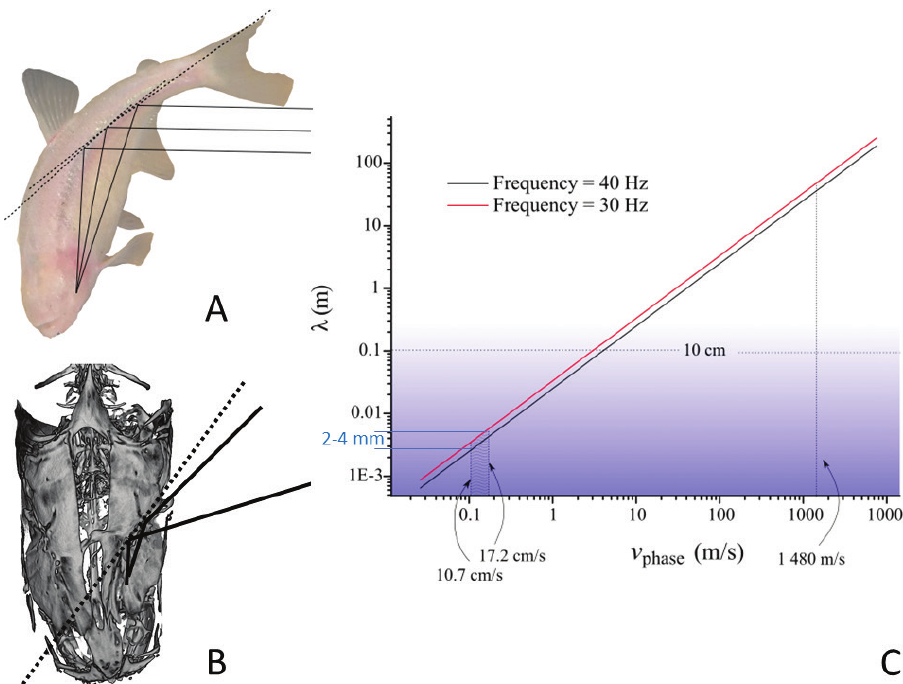
Figure 1. A schematic depiction of a plane wave (rays) reflected on the fish’s body. In this case, the waves are being amplified towards the head neuromasts. The black dotted lines represent tangents to the fish lateral line at the reflection points B deflection of plane waves on the bent skull of a cavefish C wavelength is plotted against every phase velocity between 2 cm/s and 10,000 m/s (logarithmic scale). The blue shade aims to highlight the wavelength region for which parabolic amplifiers can work in a 10 cm long fish. Clearly, the speed of sound (1,480 m/s) is off limits for frequencies at around 35 Hz, but surface ripples that travel at 10.7–17.2 cm/s are within the proper wavelength range to be efficiently reflected by struc- tures of a minimum length of 0.2–0.4 cm. Thus, curved bodies of a fish when circling around a vibrating stimulus or a bent skull can theoretically serve as amplifiers for the ripple waves generated by prey, but not for the sound that prey also produce. Skull images modified from Gross et al.